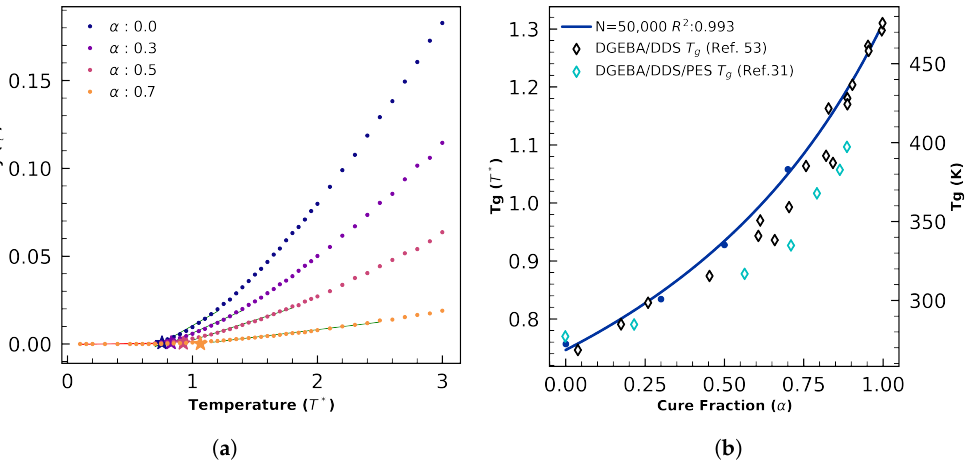
Figure 6. ( a ) Diffusivities measured from quenches of 44DDS/DGEBA/PES as a function of cure fraction and temperature. Green lines indicate linear fits of mid-T diffusivities used to calculate T g , which are indicated by stars. ( b ) T g ( α ) (blue symbols) and the DiBenedetto fit (blue curve) from ( a ). The simulated T g at low and high cure fractions shows close agreement with T g values measured from an experimental 44DDS/DGEBA system [70] (open black diamonds) and 44DDS/DGEBA/PES [5] (open cyan